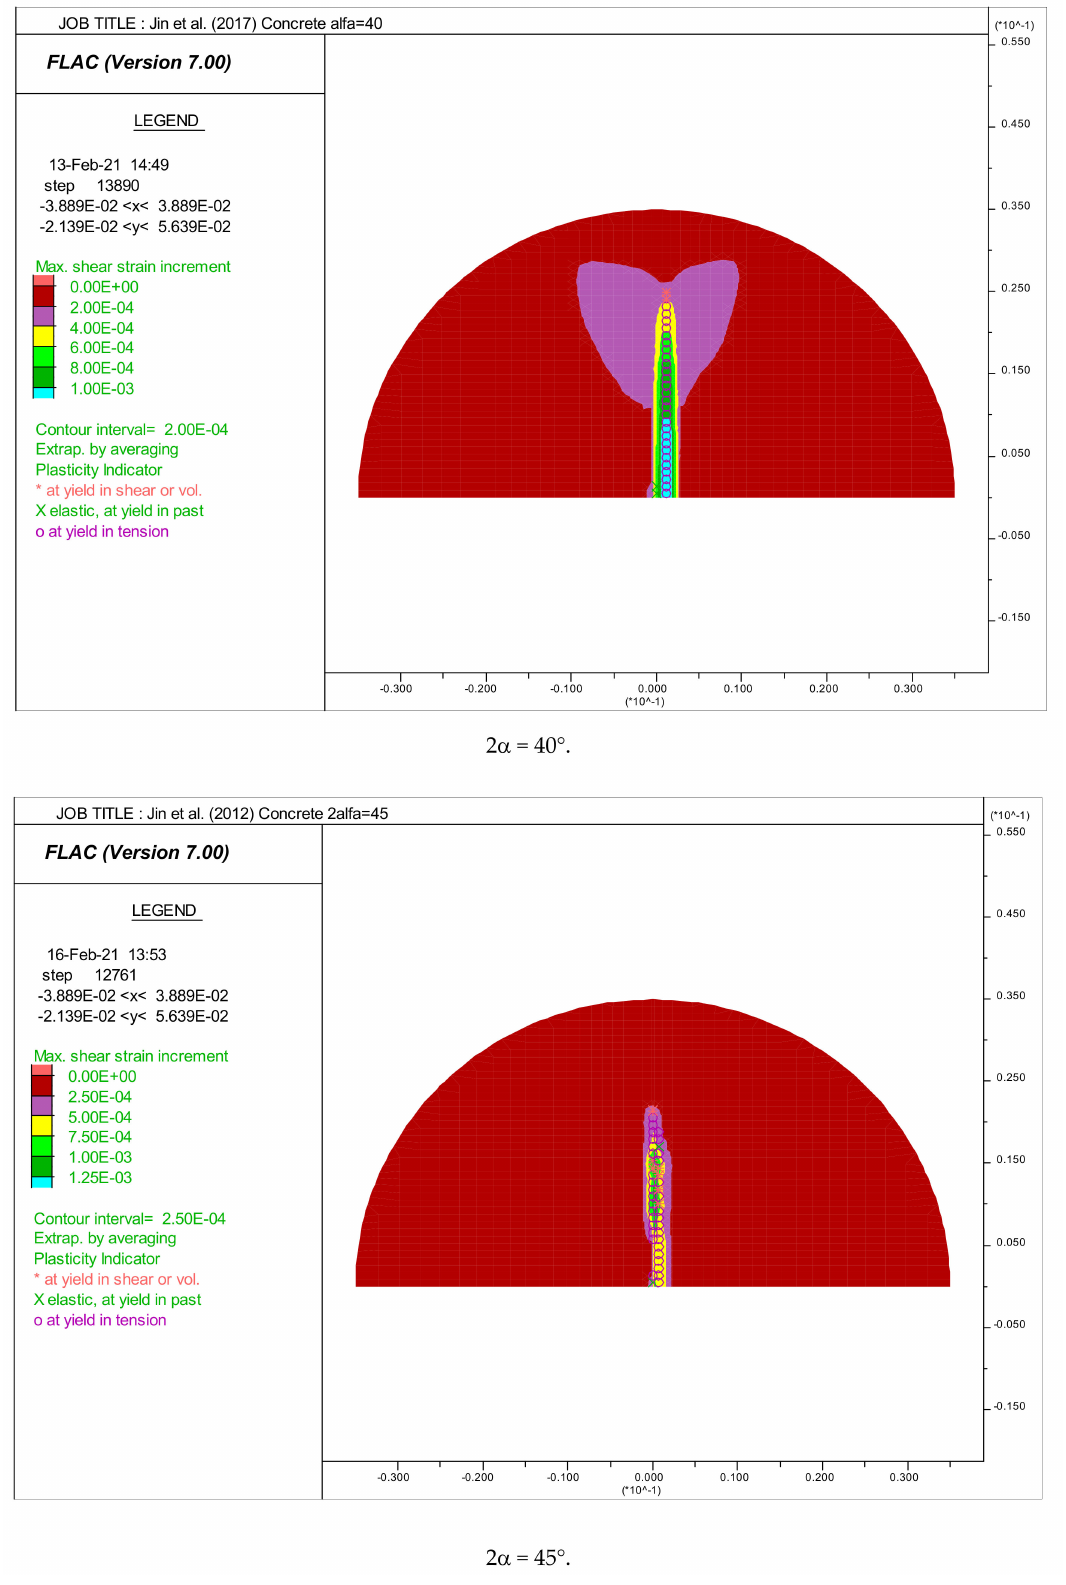
Figure 6. Distribution of maximum shear strains. Crack initiation point positions in the disk of concretes tested by